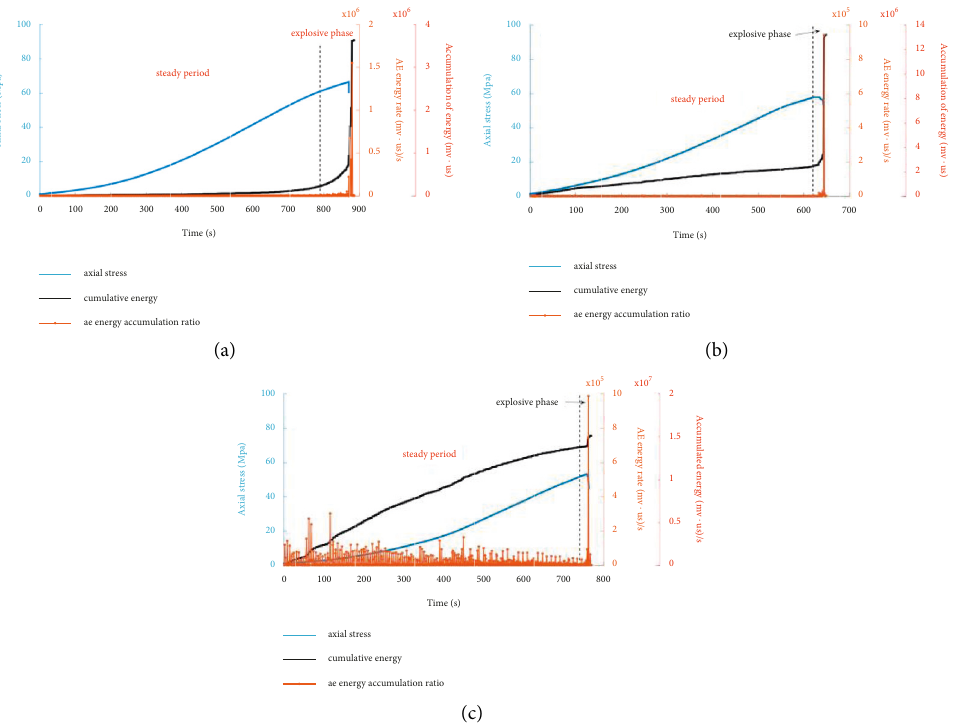
Figure 17: AE energy rate, cumulative energy and stress-time curve of yellow sandstone. (a) 20 cycles. (b) 30 cycles. (c) 40 cycles.